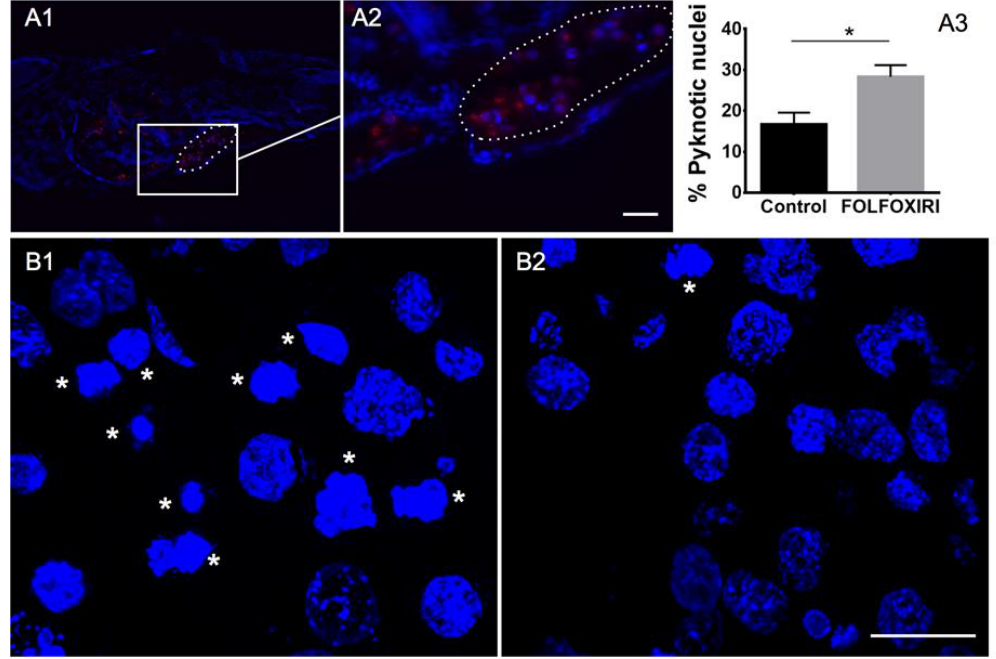
Figure 4. Cancer cell engraftment into zebrafish embryos 2 days after injection. ( A1 – A2 ) HCT 116 cancer cell line DiI labeled (red) injected into the yolk sac (circled) of zebrafish embryo 2 dpf. ( A3 ) Quantification of pyknotic nuclei by HCT 116 cancer cells xenotransplanted after two days of FOLFOXIRI treatment vs. control. Data are mean ± SEM, t -test, n > 15 * p < 0.05. Sections from HCT 116 cancer cells xenotransplanted in a zebrafish embryo treated with FOLFOXIRI ( B1 ) vs. control ( B2 ). Stars: cells with pyknotic nuclei. Scale bar: 50 µm.